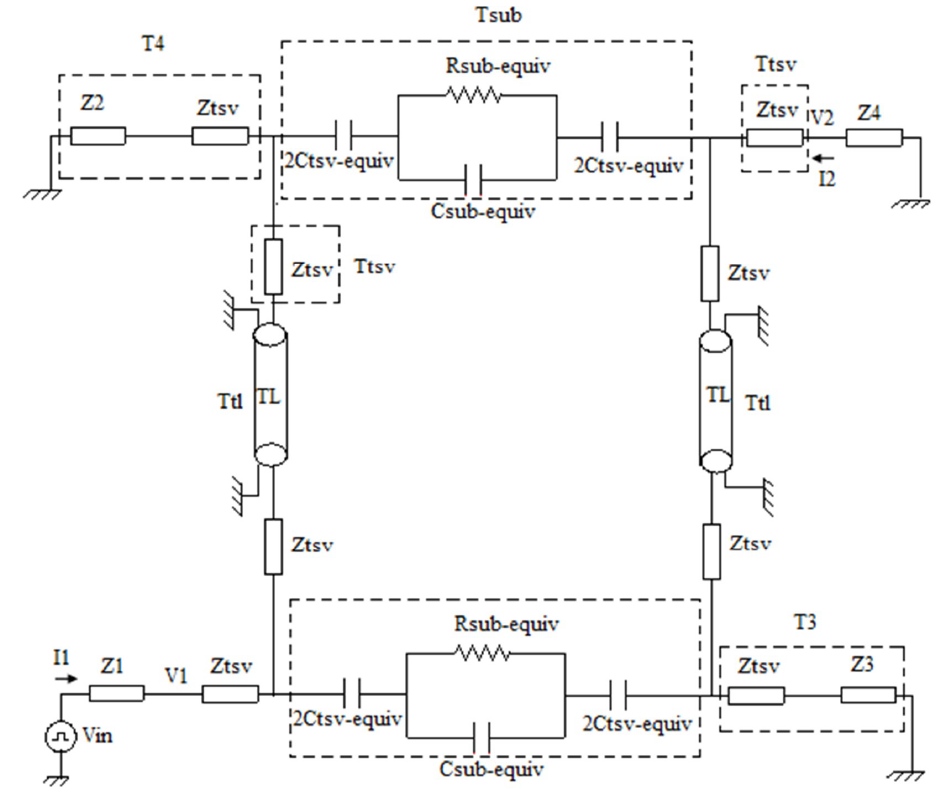
Figure 5. The equivalent circuit model of TSV noise coupling with interconnect line.